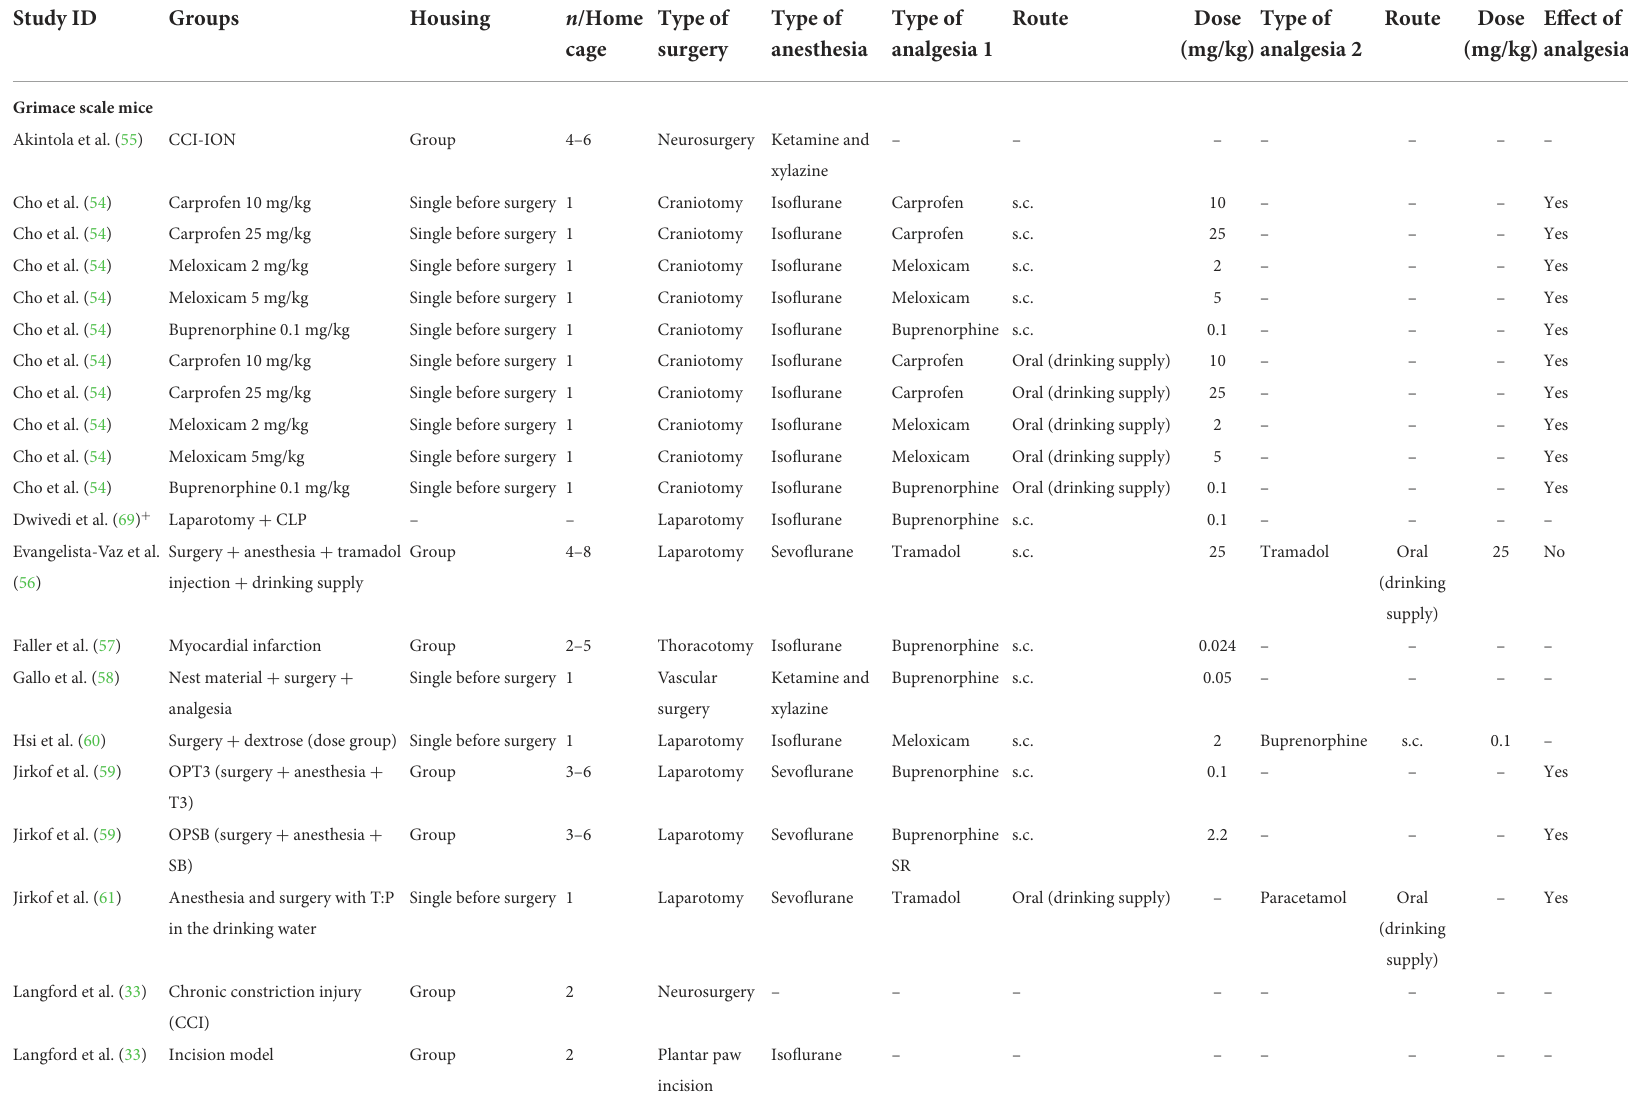
TABLE 5 Design and intervention characteristics for grimace scale, nest building, and burrowing in mice (k = 39 studies) and rats (k = 36